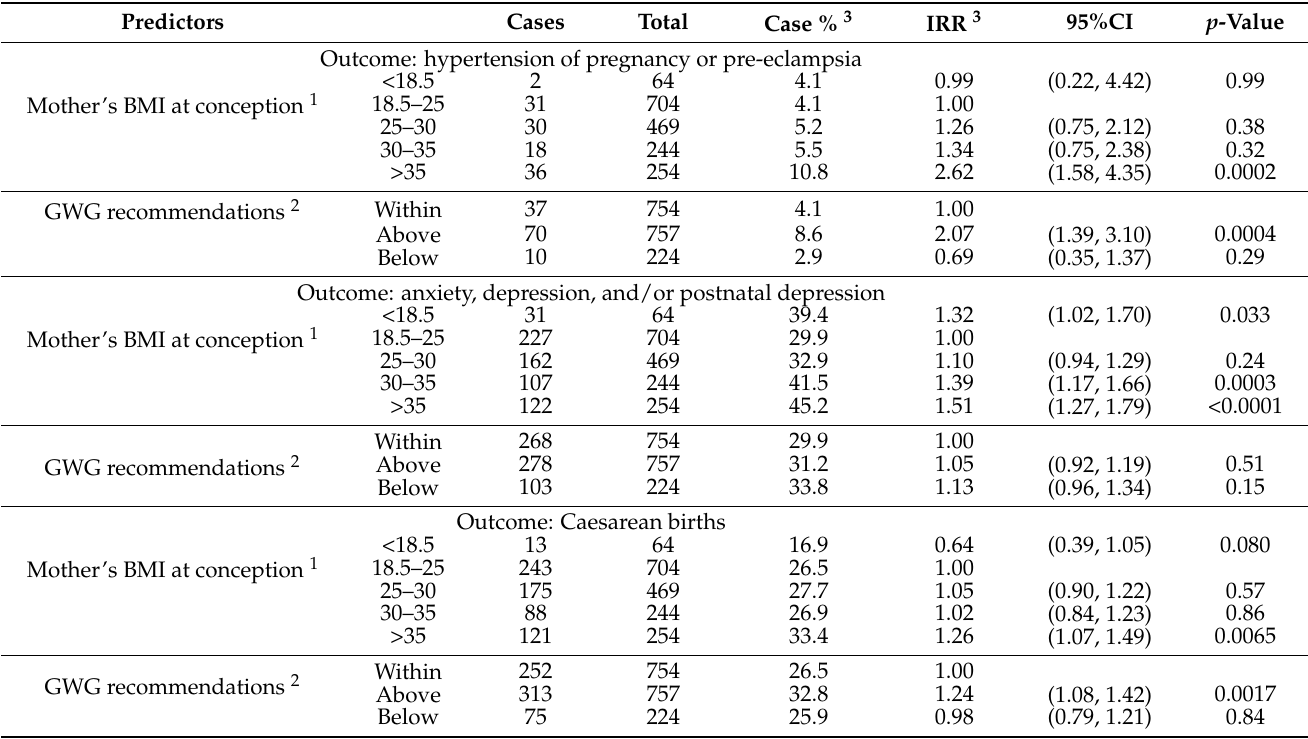
Table 1. Maternal associations of different BMI and GWG